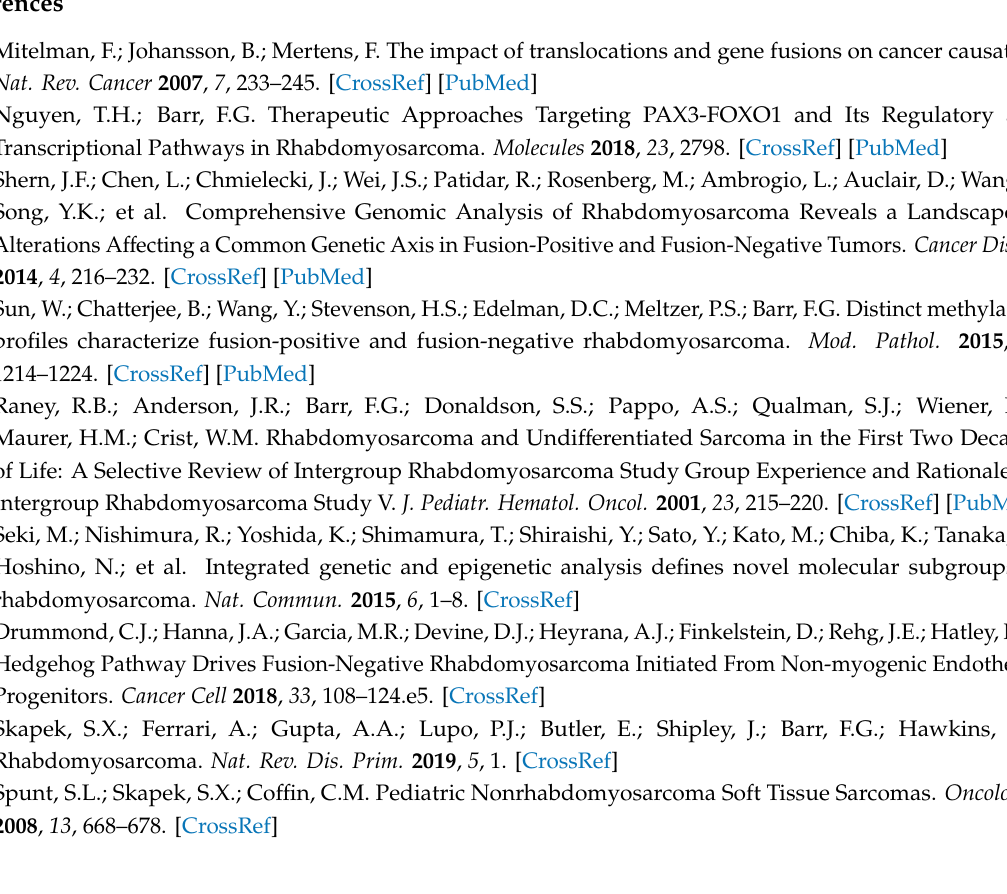
Table S1: Di ff erential expression analysis by PCA for co-expressed modules in rhabdomyosarcoma patients with and without FOXO1-PAX3 / 7 fusion with full report of statistics from permutational Anova, Table S2: Gene list enrichment of biological process and cytoband locations for gene co-expression modules that were di ff erentially regulated in fusion positive versus fusion negative rhabdomyosarcoma, Table S3: Expanded Co-expression Atlas results from gene list enrichment analysis with ToppFunn for 5 largest di ff erentially regulated co-expression modules in fusion negative versus positive rhabdomyosarcoma, Table S4: Di ff erential expression analysis by PCA for co-expressed modules in rhabdomyosarcoma patients with FOXO1-PAX3 / 7 fusion, Table S5: Top 5 Co-expression Atlas (ToppFunn) results from gene list enrichment for genes that were di ff erentially co-expressed PAX3 versus PAX7 fusion positive rhabdomyosarcoma, Figure S1: The distribution of max gene expression values per probe and within gene expression variance of raw data from GSE 66533, Figure S2: Heatmap plots of normalized gene expression values for 41 co-expression modules that were identified using lmQCM network